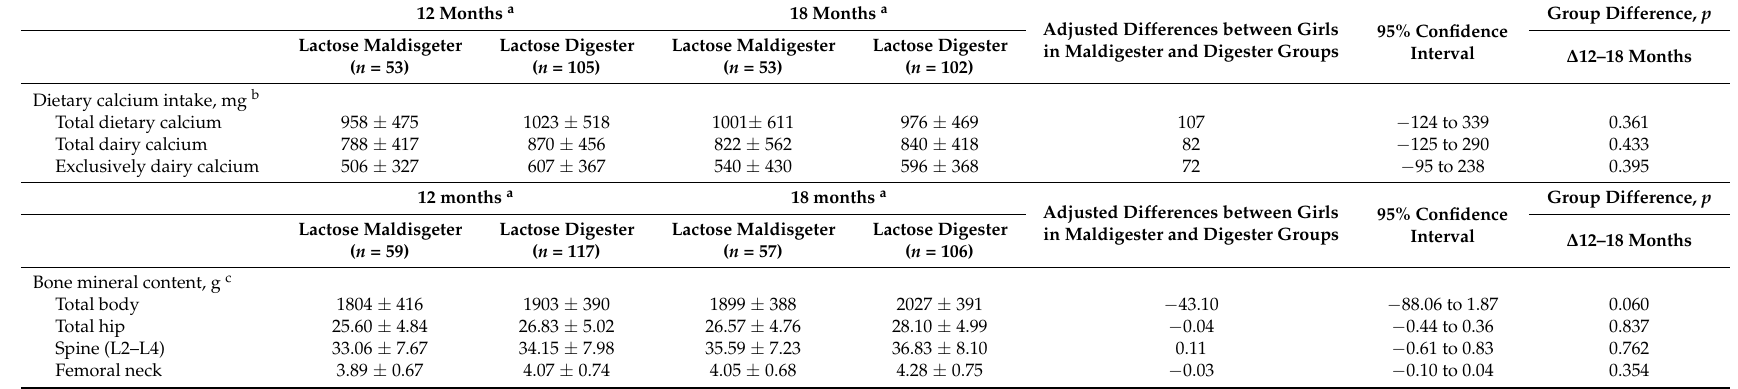
Table A2. Calcium intake and bone mass among early adolescent girls in the control group based on lactose digestion status at 12 months and change at second follow-up visit at 18